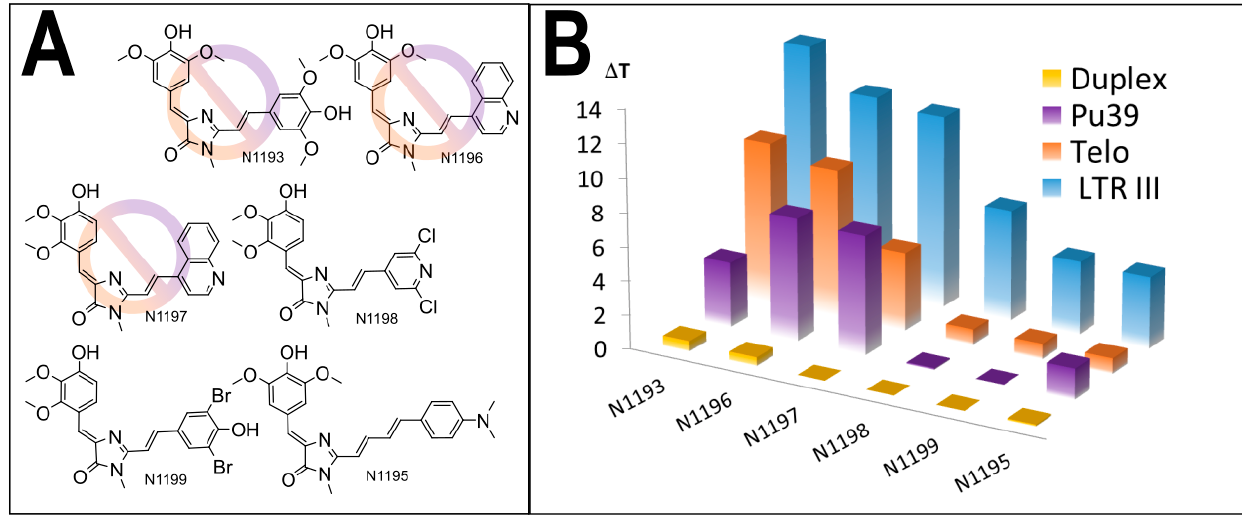
Figure 3. The designed GFP-chromophore-based LTR-III G4 ligands: ( A ) the structures of the compounds, synthesized on the basis of the SAR findings; prohibition sign corresponds to the lack of selectivity; ( B ) comparative stabilization of various DNA structures by the synthesized compounds.